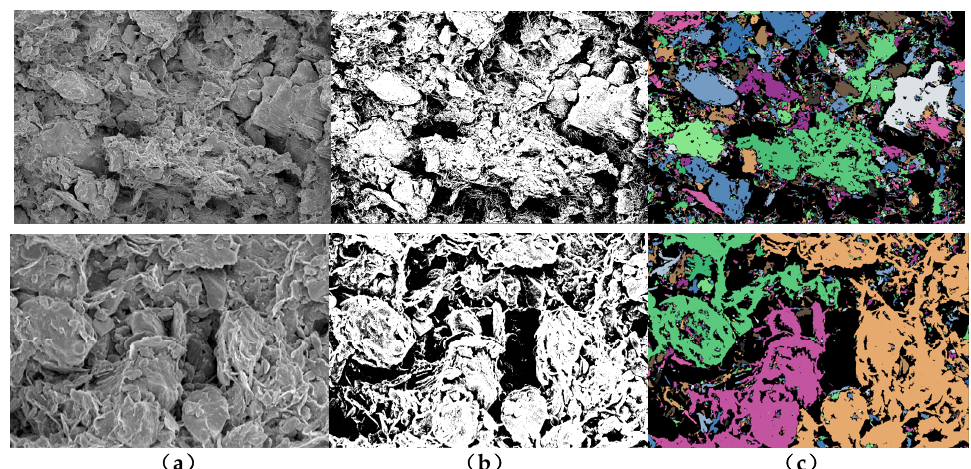
Figure 5. The process of the extraction and analysis of the microstructural parameters (the above is magnified 2000 times, and 10,000 times below). ( a ) Image preprocessing; ( b ) threshold segmentation; ( c ) morphological processing.